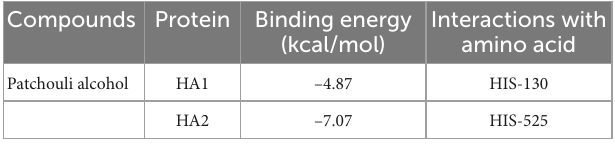
TABLE 4 In silico Patchouli alcohol and HA docking studies.